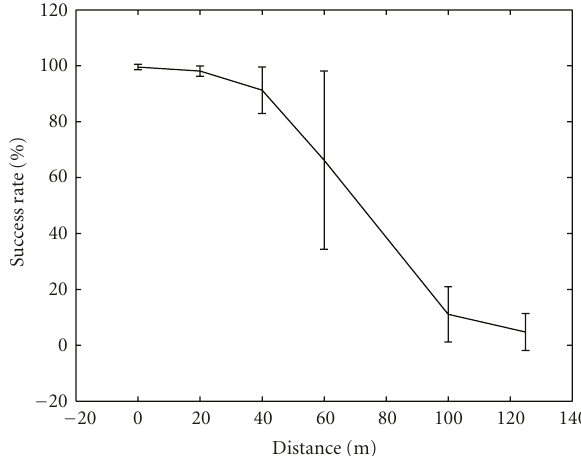
Figure 10: CSN-to-CSN range test. This test was conducted across a field with waist-high vegetation. Both collars were elevated 2 m. Bars indicate one standard deviation.